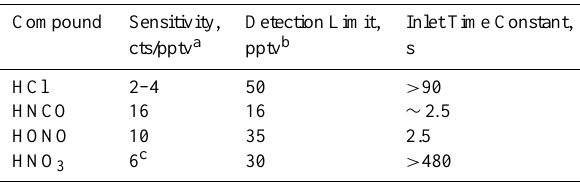
Table 3. Summary of sensitivities, detection limits and time constants.